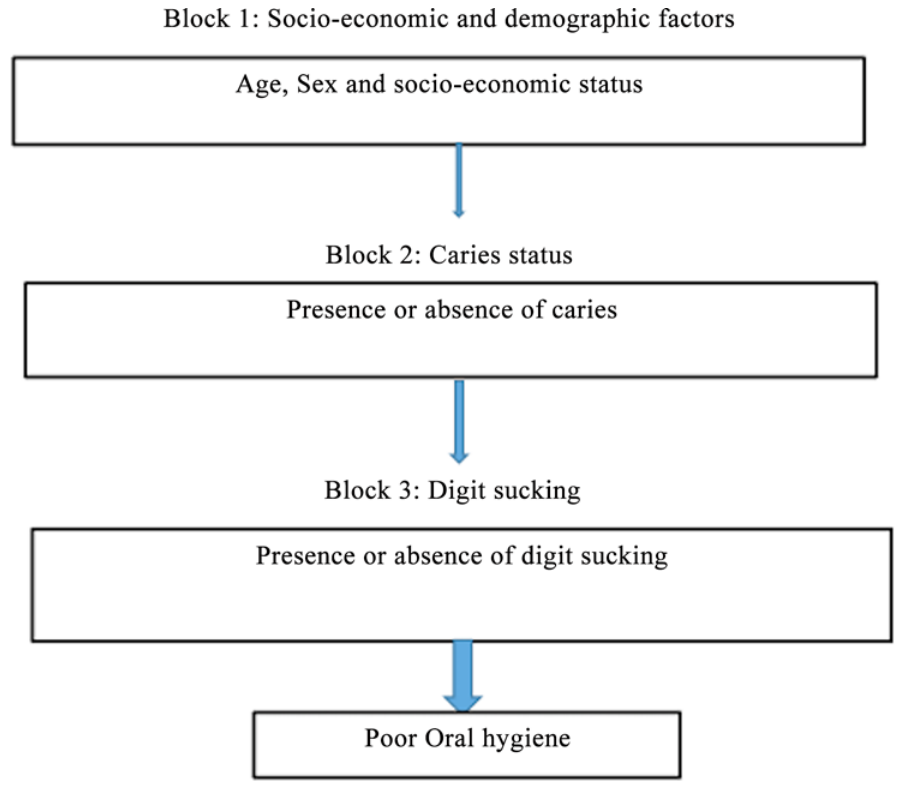
Fig 2. Hierarchical model for analysis of predictors of poor oral